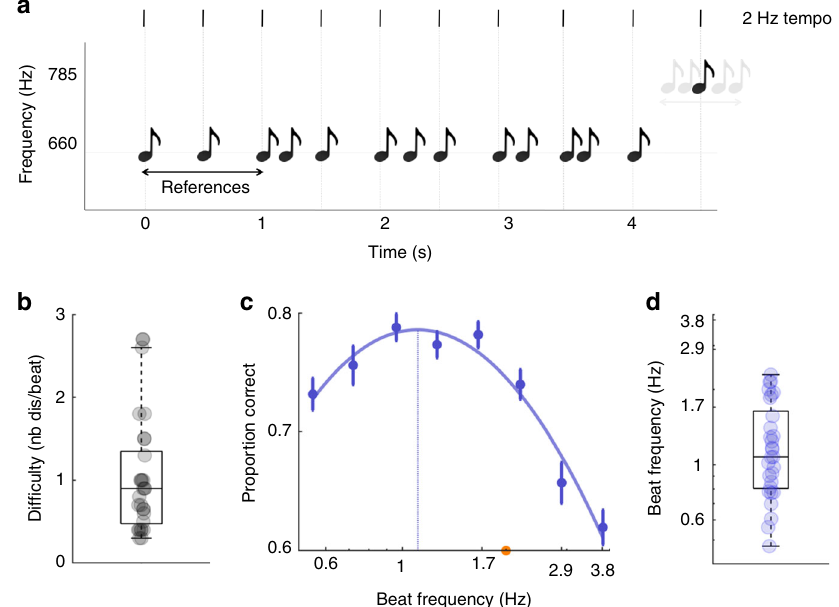
Fig. 1 Passive auditory experiment: experimental design and results. Experiment 1. a Sequences of pure tones were presented binaurally on each trial. Three reference tones de fi ning the beat frequency (or tempo; vertical lines) of the sequence preceded a mixture of on-beat and off-beat tones. Participants performed a beat discrimination task at the end of each trial, by deciding whether the last tone of the sequence, a spectral deviant (785 Hz vs. 660 Hz), was on or off beat. The beat frequency varied across conditions (from 0.6 Hz to 3.8 Hz). b Individual dif fi culty level to reach threshold performance for a 2 Hz tempo. Dif fi culty was modulated by adjusting the density of distractors in the sequence (number of distractors per beat). c Average performance per condition (beat frequency). Data were approximated with a polynomial function (plain line), and an optimal tempo (leading to a maximal performance) could be estimated (vertical line). The orange dot indicates the tempo (2 Hz) that served to estimate the individual dif fi culty level. d Individual estimates of the optimal tempo. One outlier participant (4.5 Hz) is not visible. Error bars indicate s.e.m. ( n = 30). Boxplots represent median and 1.5 times the interquartile